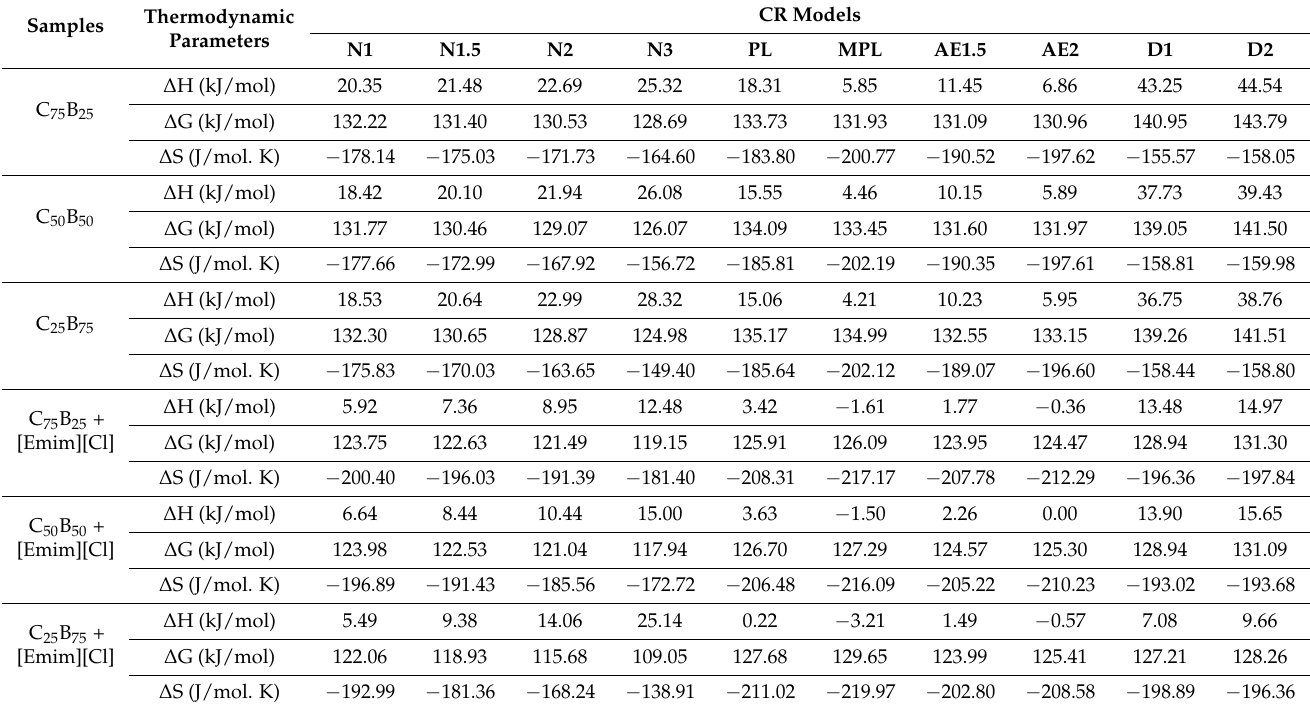
Table 3. Thermodynamic parameters calculated for untreated and IL treated